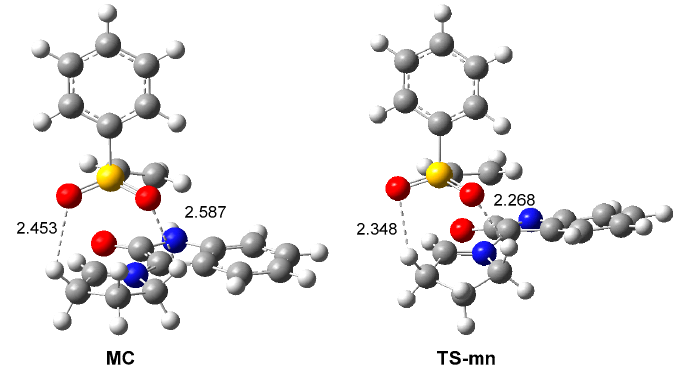
Figure 5. ω B97X-D/6-311G(d,p) geometries of MC and TS-mn showing the distances of the two O–H HBs. Distances are given in angstroms, Å.